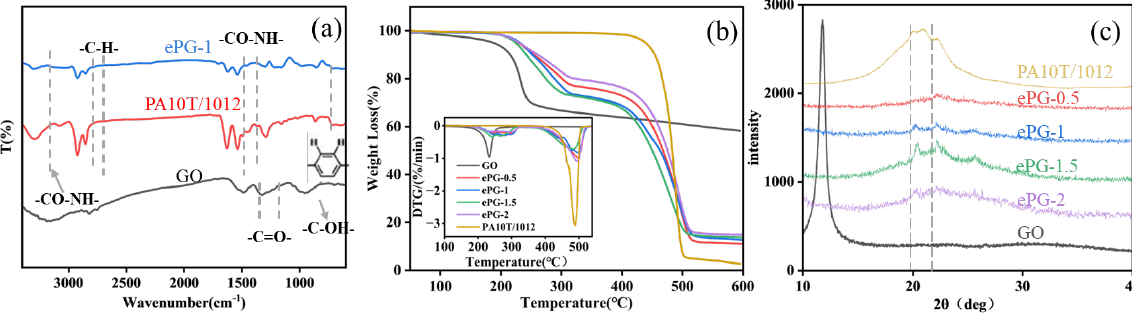
Figure 1. Characterization of GO, PA10T/1012 and ePG ( a ) FTIR spectra; ( b ) TGA and DTG curves; ( c ) XRD patterns.